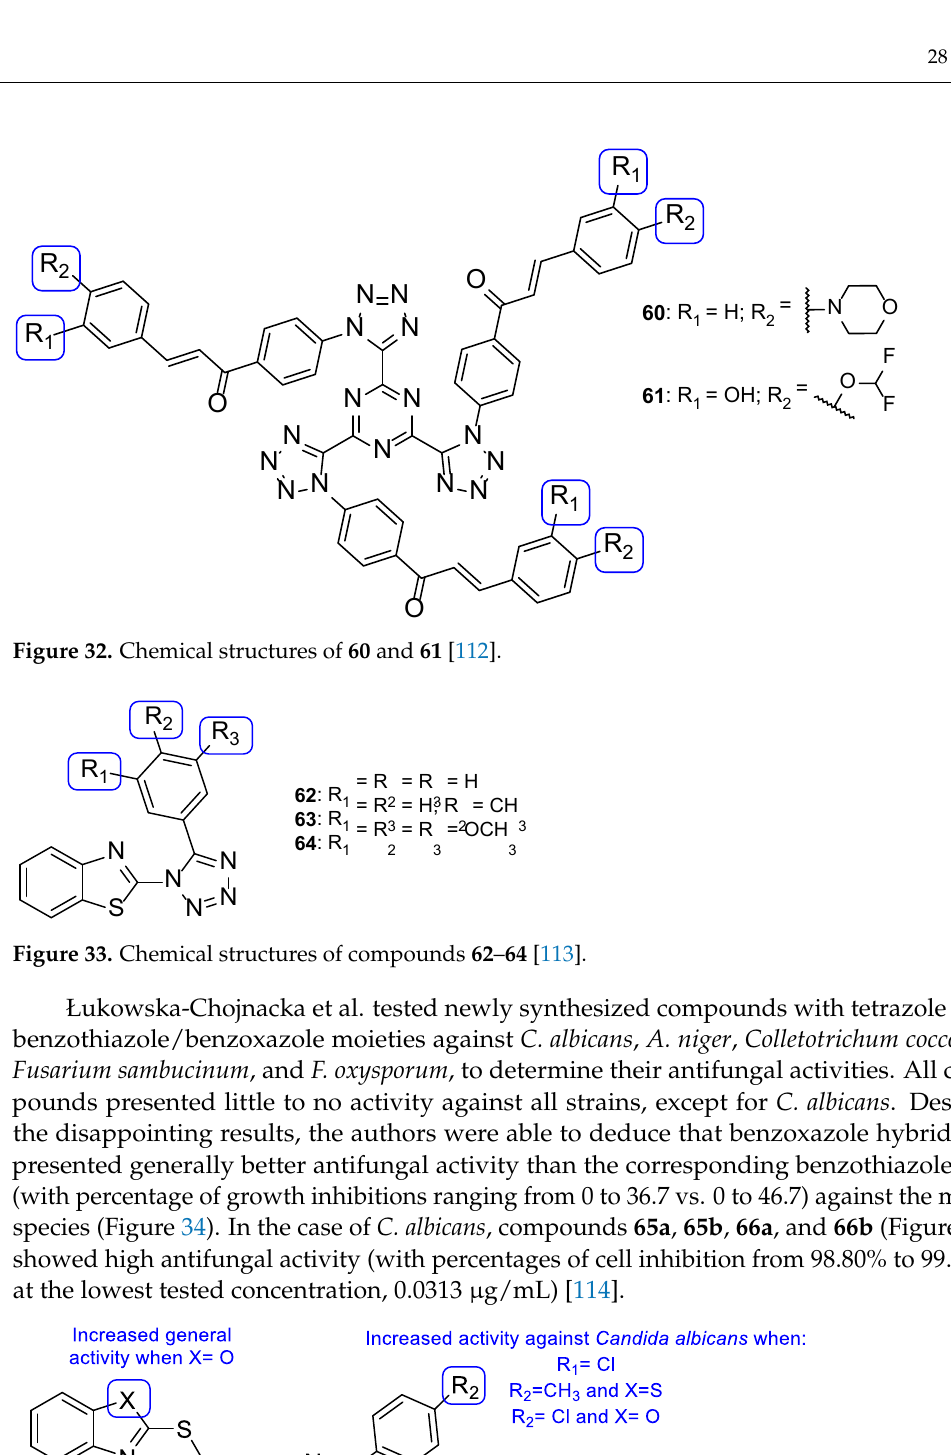
Figure 33. Chemical structures of compounds 62 – 64 [113]. Łukowska -Chojnacka et al. tested newly synthesized compounds with tetrazole and benzothiazole/benzoxazole moieties against C. albicans , A. niger , Colletotrichum coccodes , Fusarium sambucinum , and F. oxysporum , to determine their antifungal activities. All com- pounds presented little to no activity against all strains, except for C. albicans . Despite the disappointing results, the authors were able to deduce that benzoxazole hybrids 65 pre- sented generally better antifungal activity than the corresponding benzothiazoles 66 (with percentage of growth inhibitions ranging from 0 to 36.7 vs. 0 to 46.7) against the mold species (Figure 34). In the case of C. albicans , compounds 65a , 65b , 66a , and 66b (Figure 34) showed high antifungal activity (with percentages of cell inhibition from 98.80% to 99.36% at the lowest tested concentration, 0.0313 µg/mL) [114]. Figure 34. Chemical structures of compounds 65a – b and 66a – b , and SAR [114]. Selenadiazoles are heterocyclic compounds which present various biological activities, such as antibacterial, antifungal, antitumor, among others. The addition of this moiety to known antifungal azoles, such as tetrazole, may in some cases lead to an increased activity. In 2015, Kanakaraju and Suresh designed a new series of hybrids using tetrazole and selenadiazoles and evaluated the antifungal activity using the broth microdilution method against C. albicans and A. niger . All tested compounds, with the exception of 67 and 68 (Figure 35), presented only weak antifungal activity against both strains. Com- pound 67 showed promising values when compared to fluconazole against A. niger (MIC = 14.8 µM vs. 20.4 µM) and 68 presented promising values of MIC against C. albicans (MIC = 14.8 µM vs. 20.4 µM). In the presence of the selenadiazole ring (when compared to com- pounds without it), there was an increased antifungal activity, in particular when the chlo- rine substituent was present on the phenyl ring linked to tetrazole (Figure 35) [115]. Figure 35. Chemical structures of compounds 67 and 68 and SAR against C. albicans and A. niger [115]. Later, Shaik et al. synthesized tetrazole-quinoline hybrids (2,5 ( 69 ) and 1,5-regioiso- mers ( 70 )) which were assayed for antifungal activity using the disc diffusion method against C. albicans and A. fumigatus and using fluconazole as standard. Generally, the tested compounds presented good antifungal activity for both strains, with MIC values ranging from 24 to 130 µM against C. albicans and 6.5 to 149 µM against A. fumigatus (flu- conazole presented MIC = 98 µM for both strains, which is not in concordance with liter- ature reports — fluconazole is usually inactive to A. fumigatus ). Compound 69a and 70a (Figure 36), with a bromine substituent at C-6, displayed good antifungal activity against both strains, with MIC = 24 µM. Moreover, compounds 69b and 70b (Figure 36), with a fluor substituent at C-6 and 69c and 70c (Figure 36), with a bromine substituent at C-6, showed great antifungal activity against A. fumigatus , with MIC values of 6.5, 6.5, 11.2, and 11.2 µM, respectively. The obtained results not only suggested that the 1,5-regioiso- mer presented better values of fungal inhibition, which reveals regioselectivity of the en- zyme, but also that compounds with halogen groups (such as fluorine and bromine) at the C-6 led to an increase in activity (other groups, such as methyl, methoxyl, and